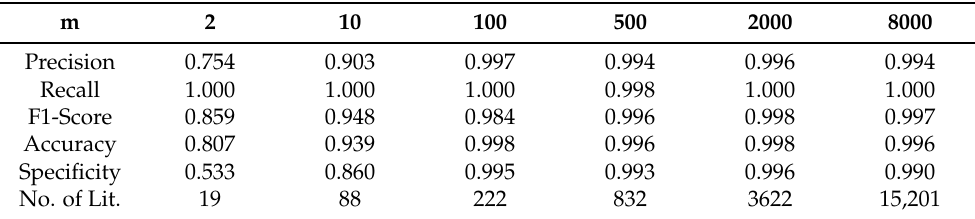
Table 8. Performance of TM with Booleanized continuous features on Bankruptcy dataset.